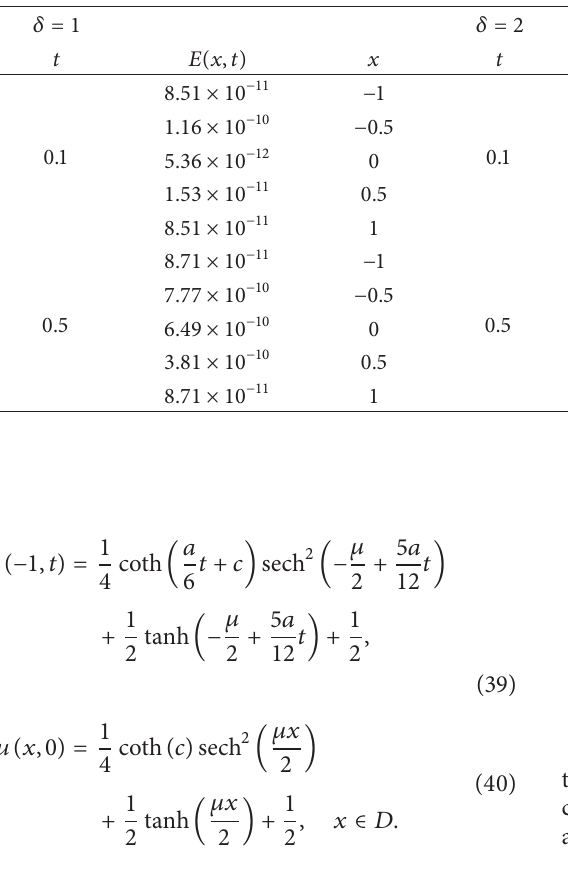
Table 2: Absolute errors for Example 2.